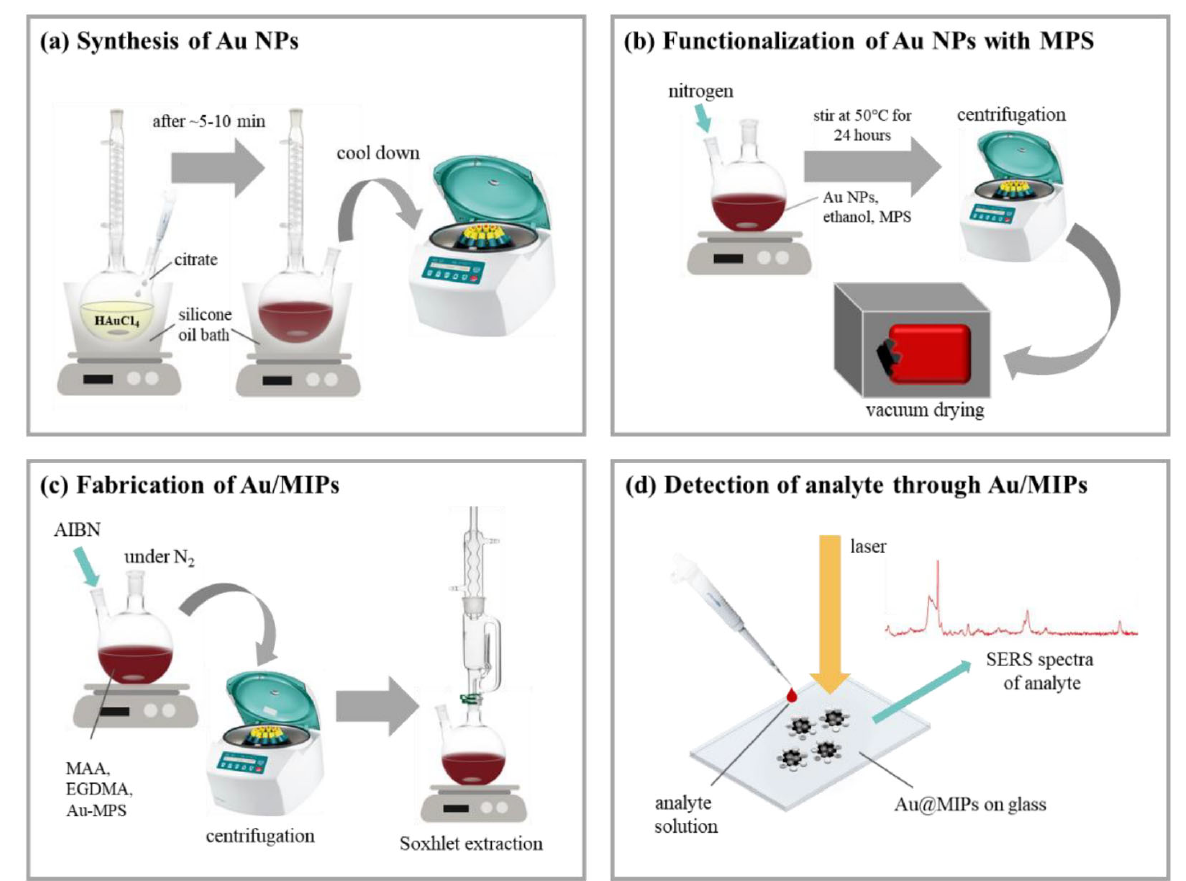
Figure 5. A gold (Au) nanoparticles MIP illustration for the SERS detection of the analyte cyperme- thrin